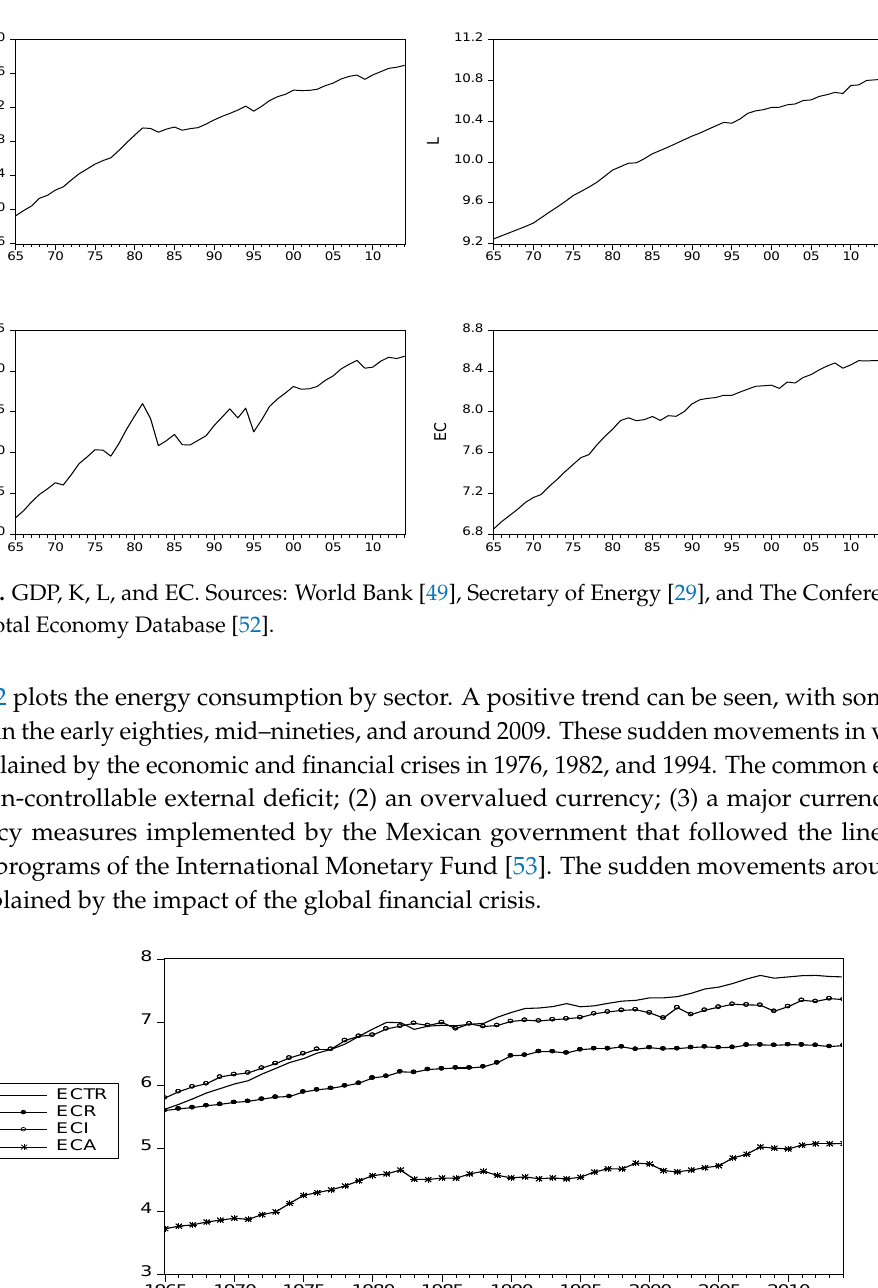
Table 1. Correlation matrix: Energy consumption and economic growth in Mexico.